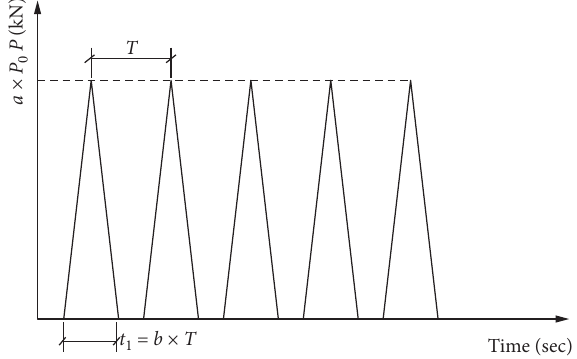
Figure 7: Simplified time history curve of jump excitation. Table 3: Measured modal data of composite